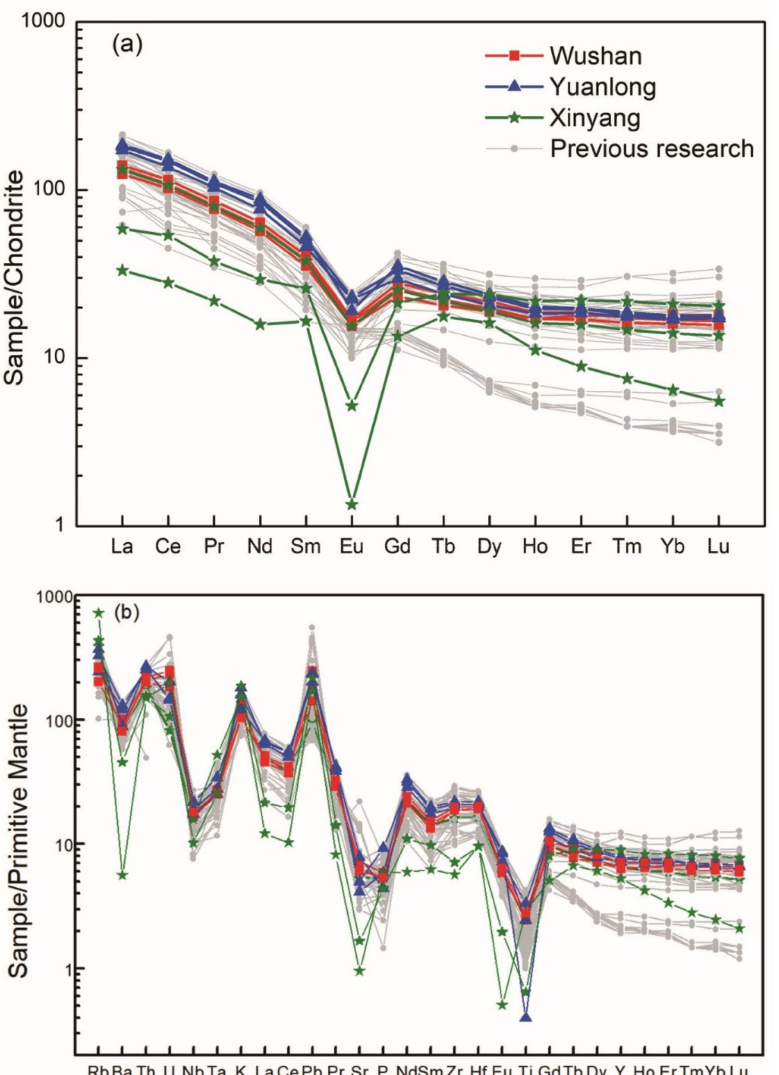
Figure 5. ( a ) Chondrite-normalized REE patterns and ( b ) primitive-mantle-normalized trace element spider diagrams of the studied samples. Data sources for the previous research: